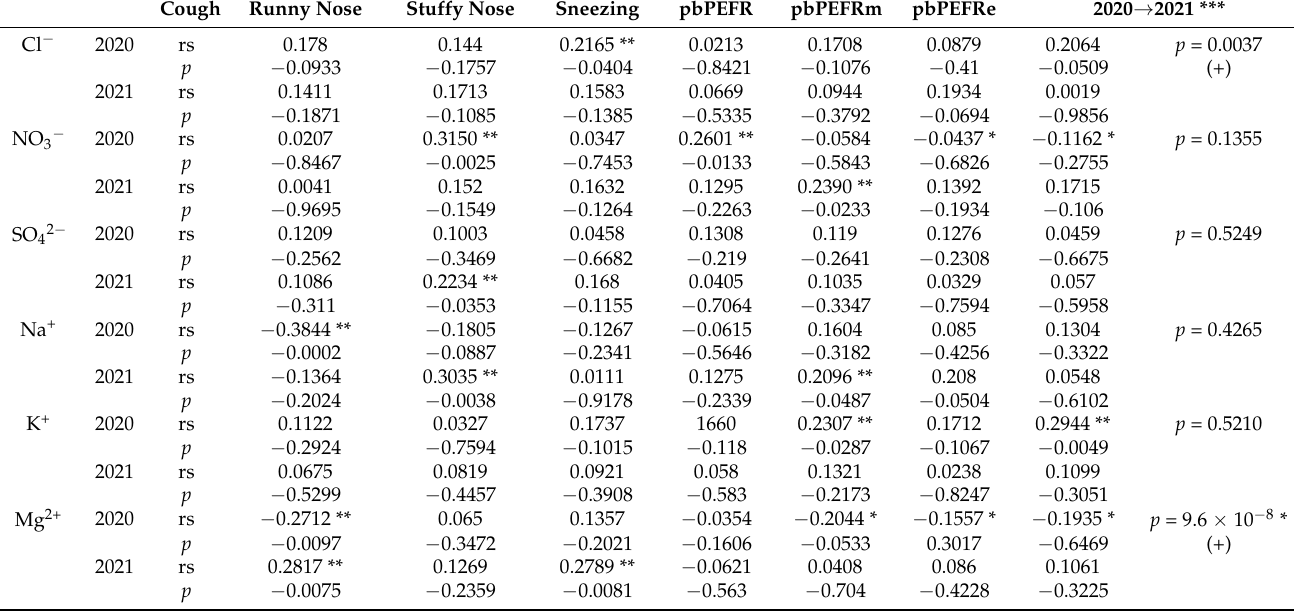
Table 3. Correlation coefficients between each ionic component and the daily prevalence of